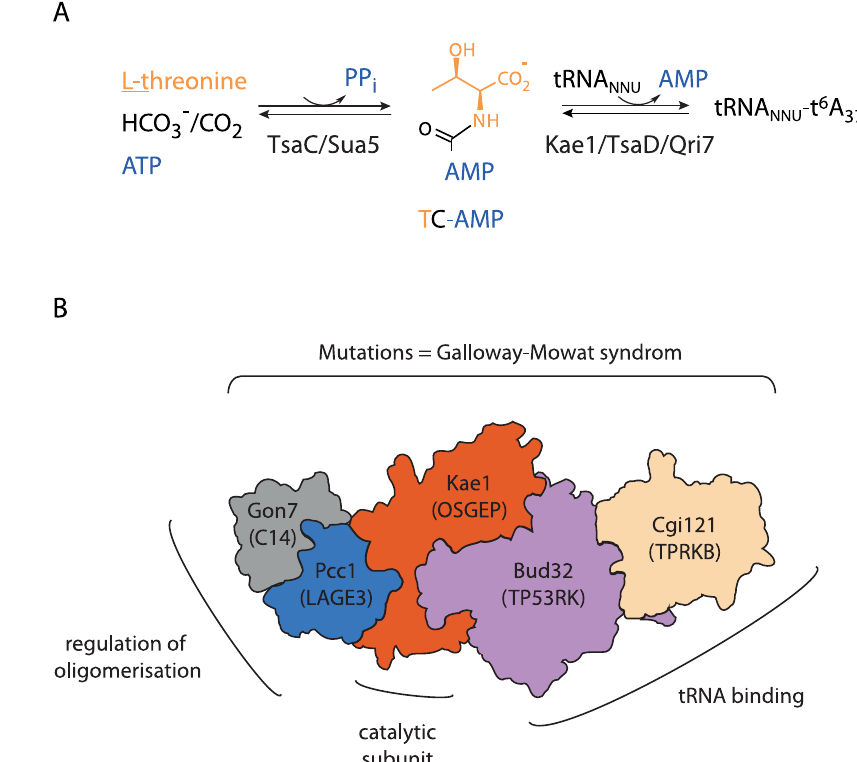
Fig. 1 | KEOPS complexstructure and functionint 6 A biosynthesis. A Enzymatic synthesis of t 6 A. Sua5/TsaC protein family catalyzes the condensation of L-threo- nine, bicarbonate or CO 2 and one ATP molecule to form an unstable intermediate threonylcarbamoyl-adenylate (TC-AMP). Kae1/TsaD/Qri7 family catalyzes the transfer of the threonylcarbamoyl moiety of TC-AMP to adenosine 37 within the anticodon loop to form t 6 A modi fi ed tRNA. B Schematic representation of the KEOPS structure and functional assignment of subunits. The complex is a linear assembly of fi ve subunits Cgi121/Bud32/Kae1/Pcc1/Gon7. The names of the human orthologsaregiveninthebrackets.Gon7/C14subunithasbeenfoundonlyinfungi and animals. The shape of each subunit roughly recapitulates the